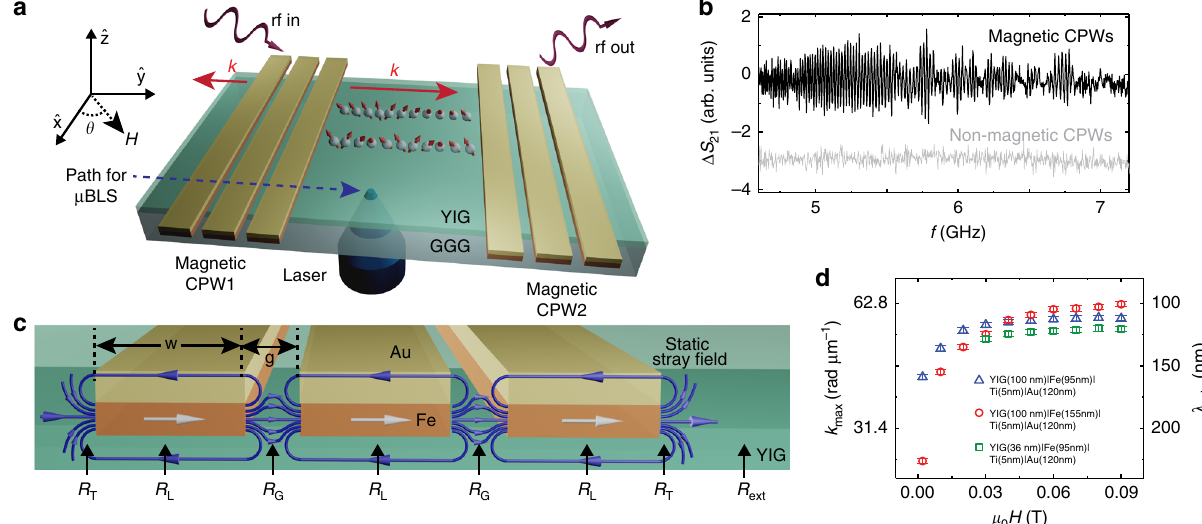
Fig. 1 Schematic diagram and high-frequency modes emitted by mCPWs. a Sketch of the experiment showing mCPWs on YIG and microfocus BLS performed through the GGG substrate. The red arrows indicate propagation directions of magnons. The blue arrow indicates the path along which local BLS spectra were obtained. b Δ S 21 re fl ecting propagating magnons (oscillatory signal) detected electrically at 0.09 T ( θ = 88°) with mCPWs (black) and the signal obtained by nonmagnetic conventional CPWs (gray). c Schematic diagram of the stray fi eld generated by Fe layers around an mCPW. White arrows display the magnetization component along the fi eld applied at θ = 90°. Blue lines with arrows illustrate the stray fi eld of Fe. We de fi ne regions (R) underneath ground and signal lines (L), in gaps (G), and a transition (T) region between the mCPW and the bare YIG which is denoted by region R ext further away from the mCPW. d Maximum wavevectors k (and corresponding minimum wavelengths λ ) extracted from Δ S 21 data taken on three max min samples (symbols are labeled in the inset) by considering the relevant dispersion relations in bare YIG given by Kalinikos and Slavin 38 . The error bar refers to the frequency resolution of the VNA. For each sample, the fi eld was reduced from μ 0 H = 0.09 T to 0.002 T. Source data are provided as a Source Data fi